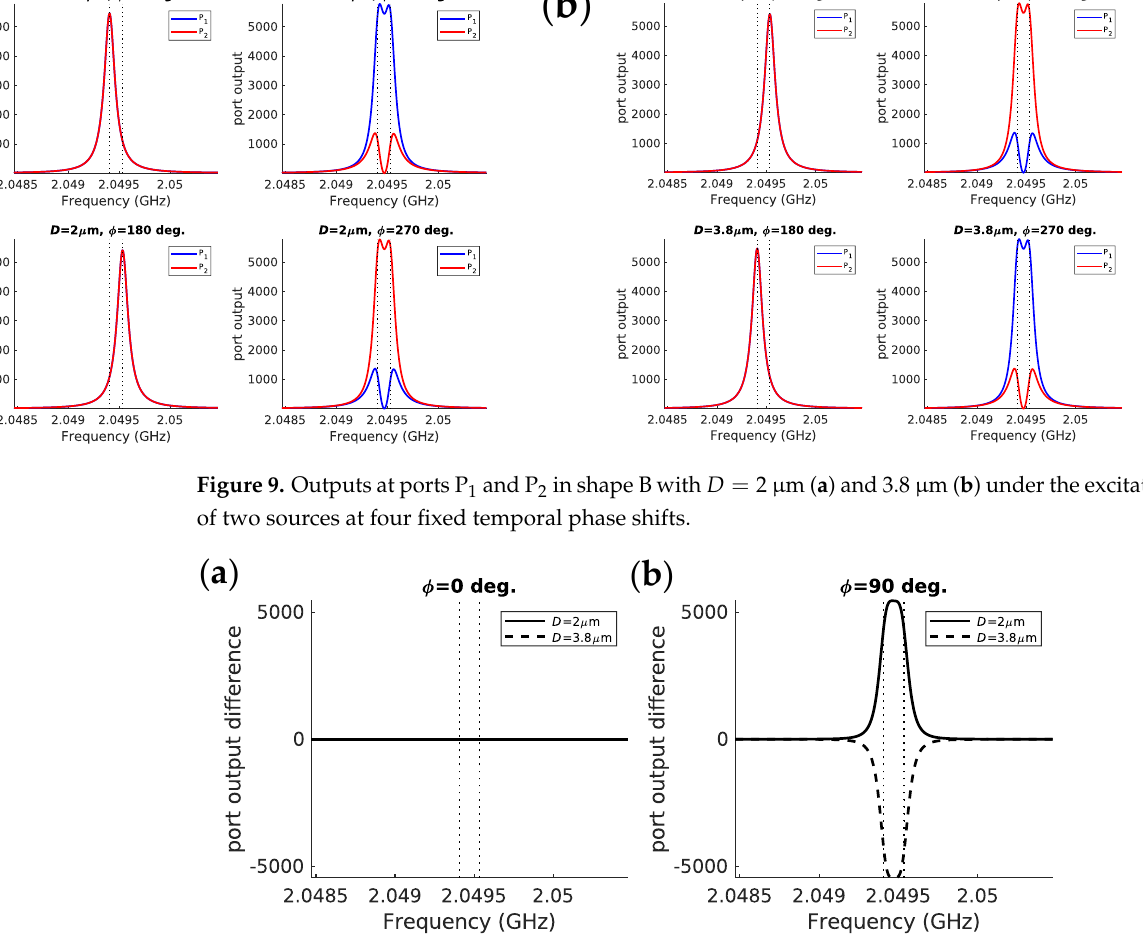
Figure 10. Difference between the output ports P 1 and P 2 in shape B with 2 D = µm (solid lines) and 3.8 µm (dashed lines) under the excitation of two sources at four fixed temporal phase shifts ( a – d ). As a matter of illustration, the spatial distribution of the x -component of the Poynting vector is presented Figure 11 for shape B for four temporal phase shifts. In the color bar, the green corresponds to the zero value of the Poynting vector, the “ blue ” and “ red ” colors